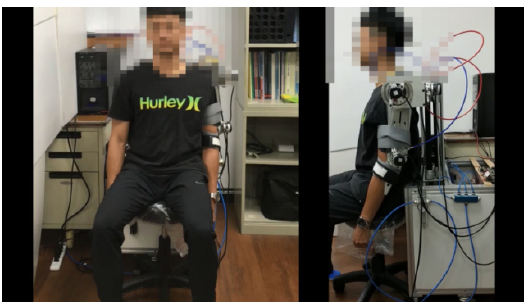
Figure 9. The subject wore the exoskeleton robot with his arms initially hanging down.